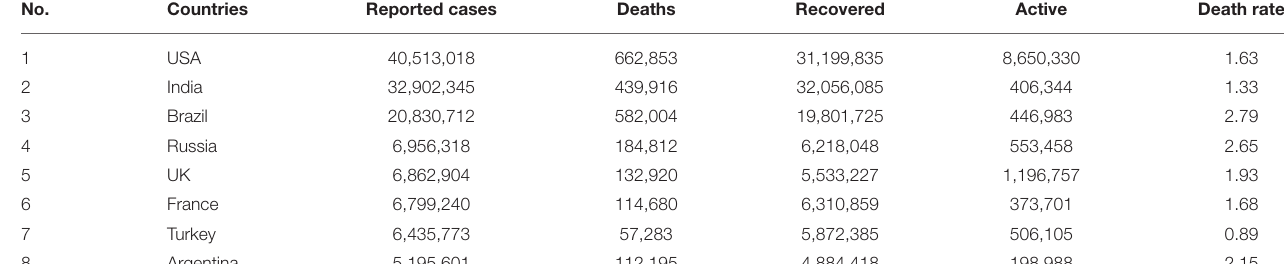
TABLE 3 | Allocation of Lab confirmed cases of eight most affected countries worldwide by COVID-19 and their death rate as on 2nd Sept 2021. No.